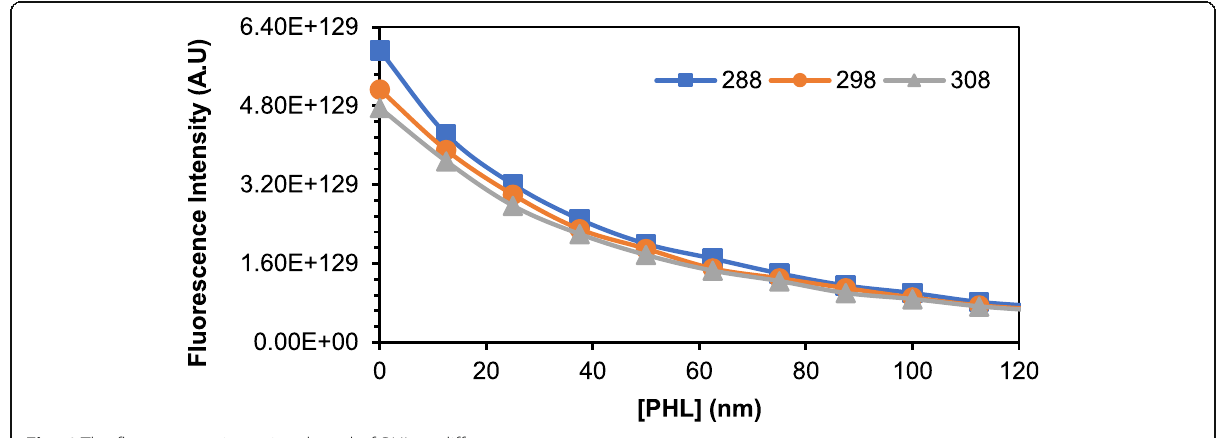
Fig. 6 The fluorescence intensity plotted of PHL at different temperatures